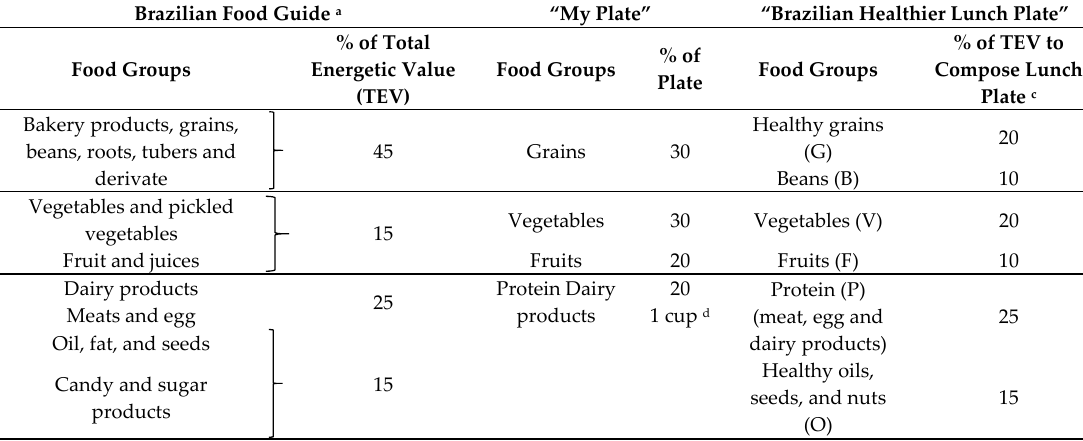
Table 1. Food Groups distribution according to Brazilian Food Guide a and “My plate” and Recommendations for the “Brazilian healthier lunch plate”.